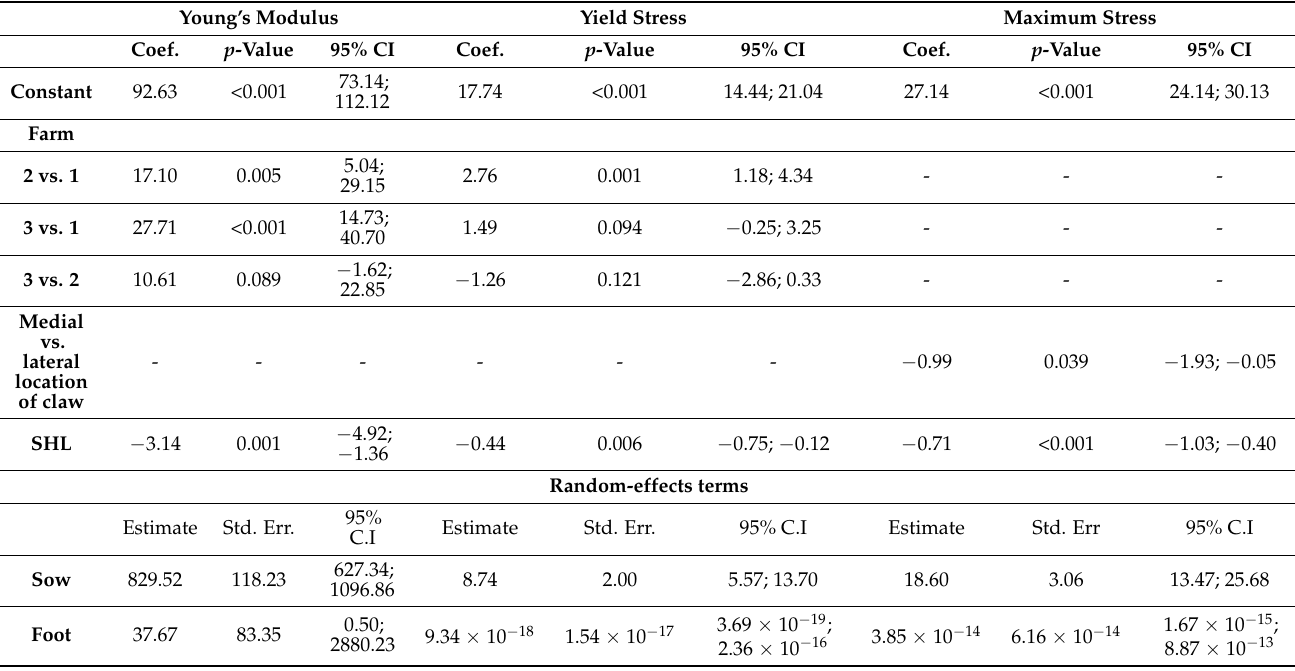
Table 4. The three final multivariable linear regression models for the association between each of the estimated mechanical indices of the hoof’s dorsal wall horn, the Young’s modulus, the yield stress, and the maximal stress, with the claw length measurements, sow’s genetic line, sow’s parity and foot or claw location in 185 culled sows from three Greek farms. Claw length measurements included: the distance from the dorsal skin-horn junction (periople) to the apex of the toe (DL), the distance from the apex of the toe to the skin-horn junction at the heel (AL) and the length of the abaxial wall (sole) and bulb (heel) that are in contact with the floor surface (SHL). In addition to the fixed-effect terms, all the evaluated models included a random-effect term for sow and a random-effect term for foot nested within sow. Young’s Modulus Yield Stress Maximum Stress